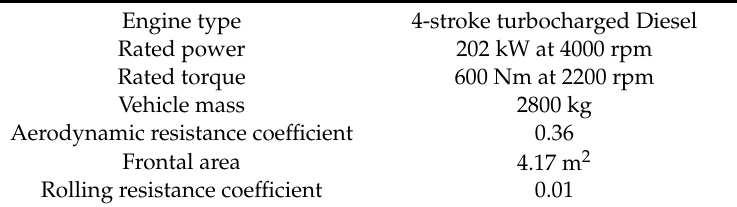
Figure 2. Instantaneous vehicle speed measured over the RDE test.